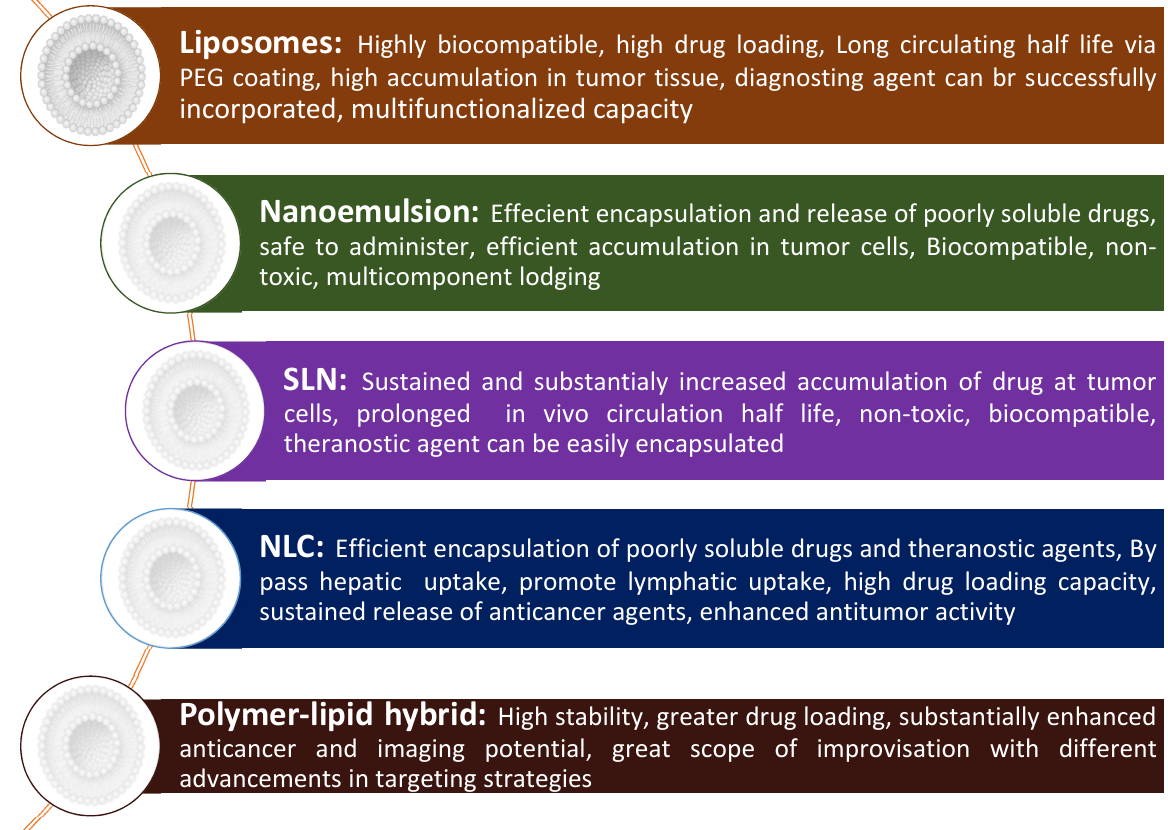
Figure 4. Different types of lipid nanoparticles viz. nanoemulsion, liposome, solid lipid nanoparticle (SLN), nanostruc- tured lipid carrier (NLC), and micelles with significant utility in cancer imaging and therapy.